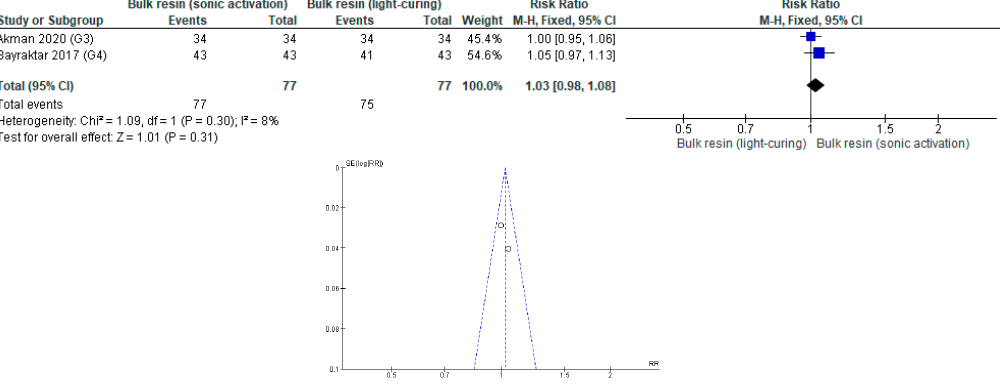
Figure A25. Absence of Secondary Caries: Bulk Resin (with Sonic Activation) versus Bulk Resin (Two-Step Technique).